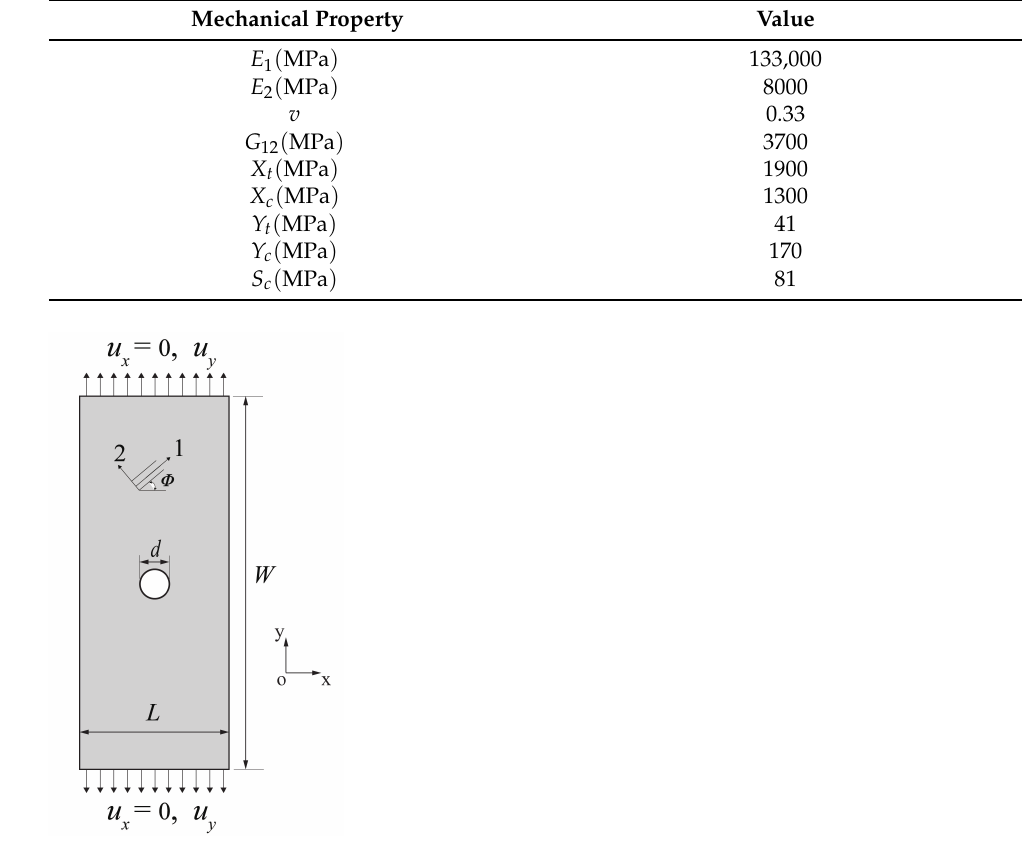
Figure 5. Sketch map for a lamina with a hole under tensile